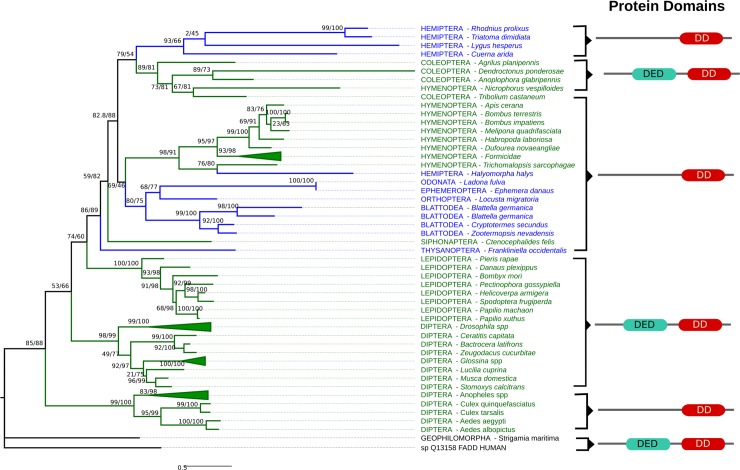
FADD Maximum likelihood trees in selected arthropods.rpFADD forms a common clade with other hemimetabolous insects, coleopterans and hymenopterans. Similar to FADD reported in mosquitoes, rpFADD only has a Death Domain (DD). The Death Effector Domain (DED) present in other orthologs was not detected in rpFADD or mosquitoes. Formicidae, Drosophila and Anopheles clades are collapsed. The human FADD ortholog was used as the outgroup.